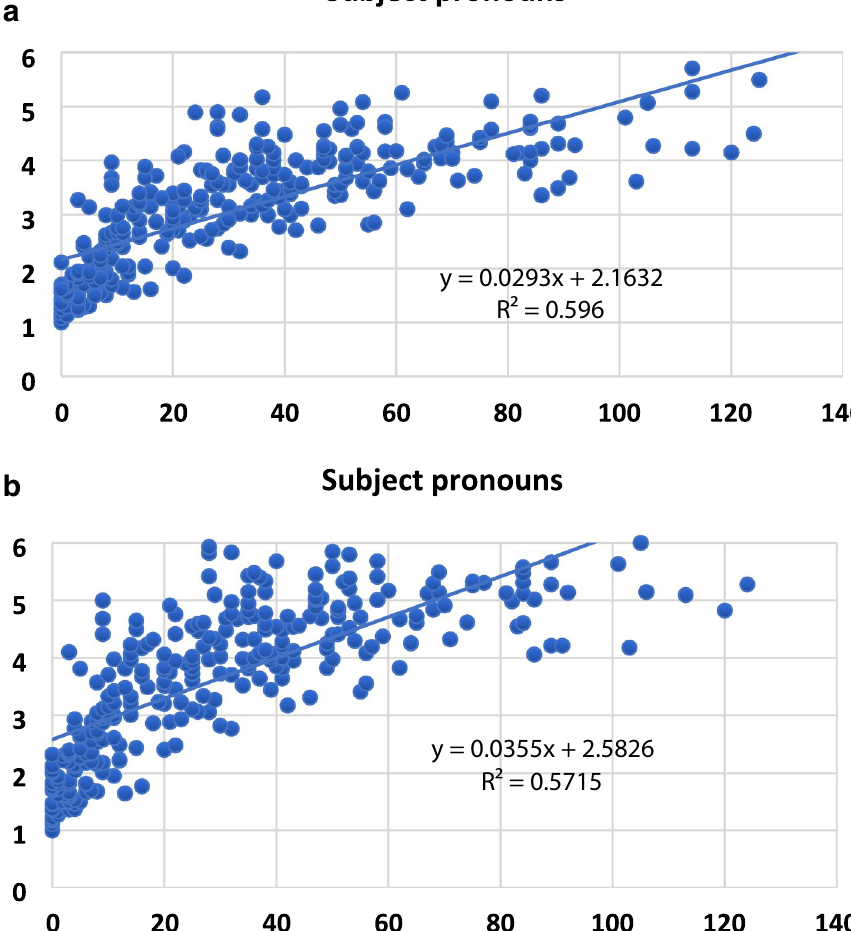
Figure 2. ( a ) Scatterplot between Subject pronouns and MLU-w. (b) Scatterplot between Subject pronouns and MLU-m.